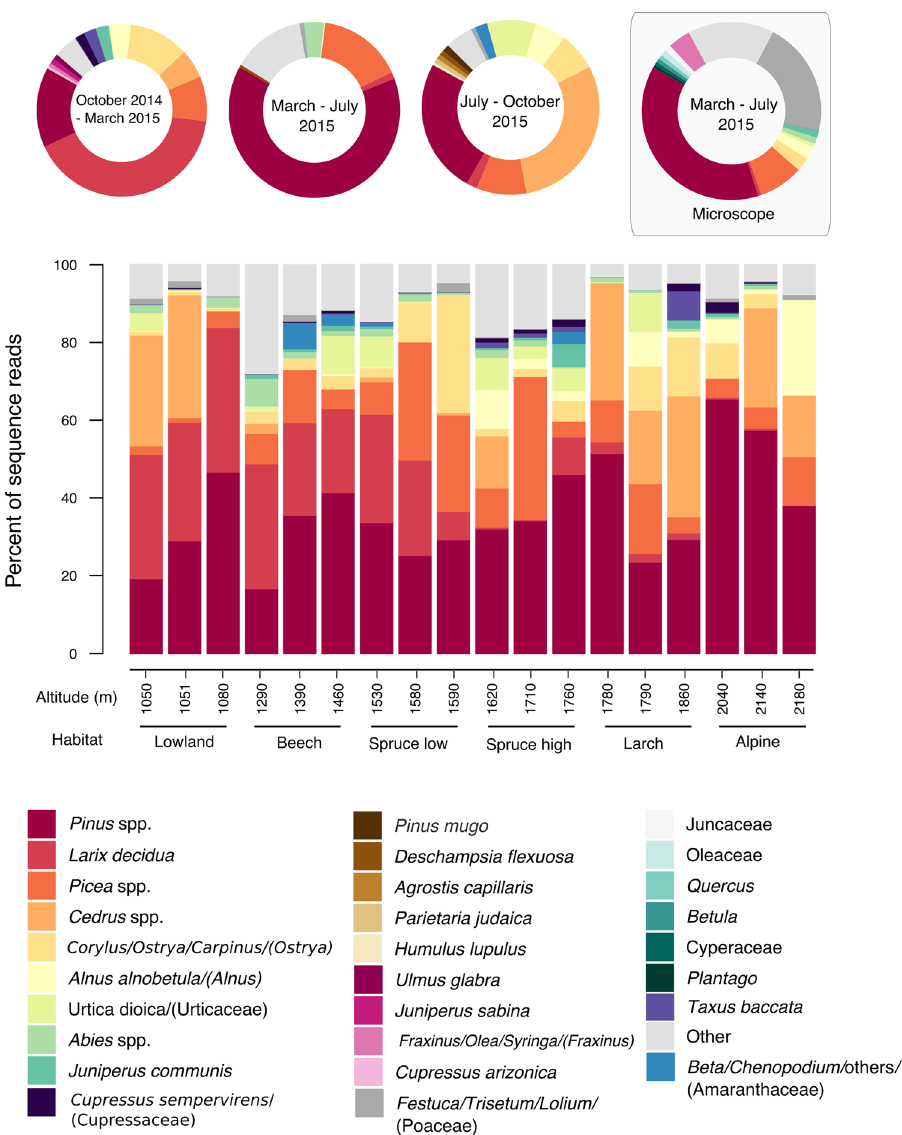
Figure 2. Taxa summary plots: Doughnut pie chart for all three sampling periods as derived by HTS and for the period March–July 2015, as derived by microscopy (up) and barplot for each sampling point (ordered in the x-axis from low to high altitudes) as derived by HTS. The charts represent relative abundance of sequences reads and microscope counts (≥ 0.5% of each period’s total for the doughnut plots and ≥ 0.5% of the annual total for the barplot). All the rest of the taxa are grouped under ‘Other’ taxa. If the level of taxonomic identification differed between methods, given in parenthesis is the level after the microscopic method. For the full plant taxa assignment data see Supplementary Table S1. The full names of the corresponding habitats are given in Table